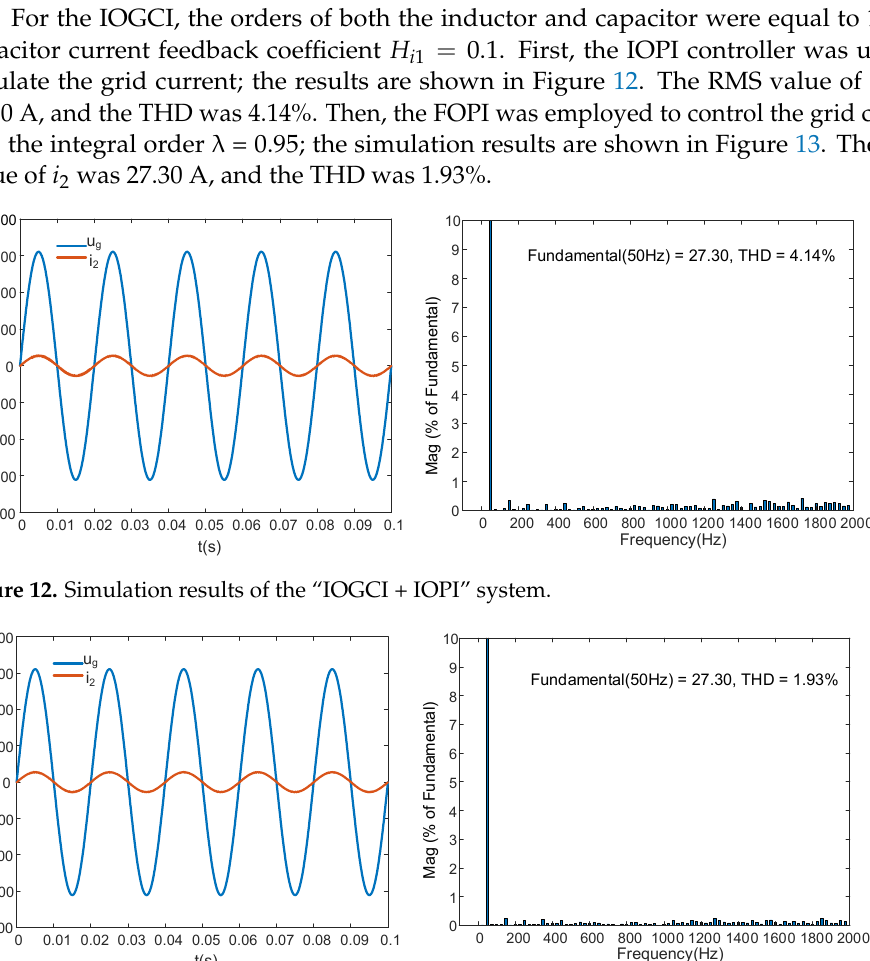
Figure 13. Simulation results of the “IOGCI + FOPI” system. For the FOGCI, the inductor order ). The capacitor current feedback coefficient used to regulate the grid current; the results are shown in Figure 14. The system was sta- 𝛽𝛽 = 2 ble, the RMS value of i 2 was 27.34 A, and the THD was 1.40%. Then, the FOPI was em- ployed to control the grid current, and the integral order λ = 0.9; the simulation results are shown in Figure 15. The system was stable, too, as the RMS value of i 2 was 27.30 A and the THD was 0.94%. 0 0.01 0.02 0.03 0.04 0.05 0.06 0.07 0.08 0.09 0.1 0100200 300 400 Figure 14. Simulation results of the “FOGCI + IOPI” system with α + β = 2.